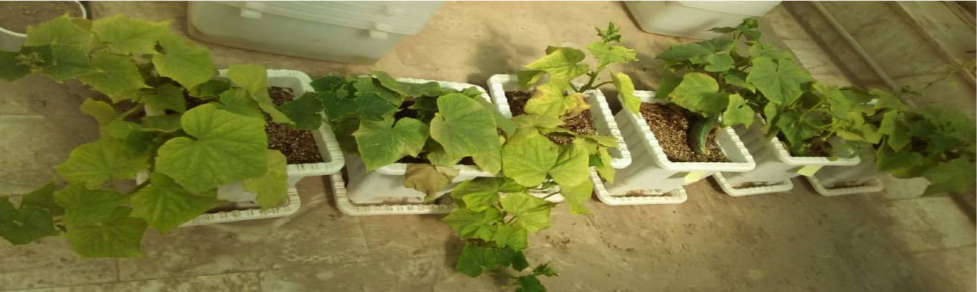
Figure 2. Overview of the cucumber pots used in the experiments.